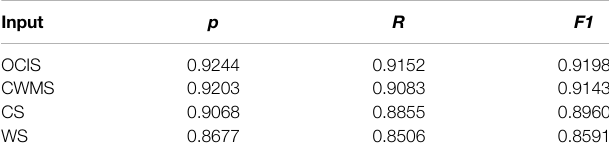
TABLE 10 | Results of the model experiment.